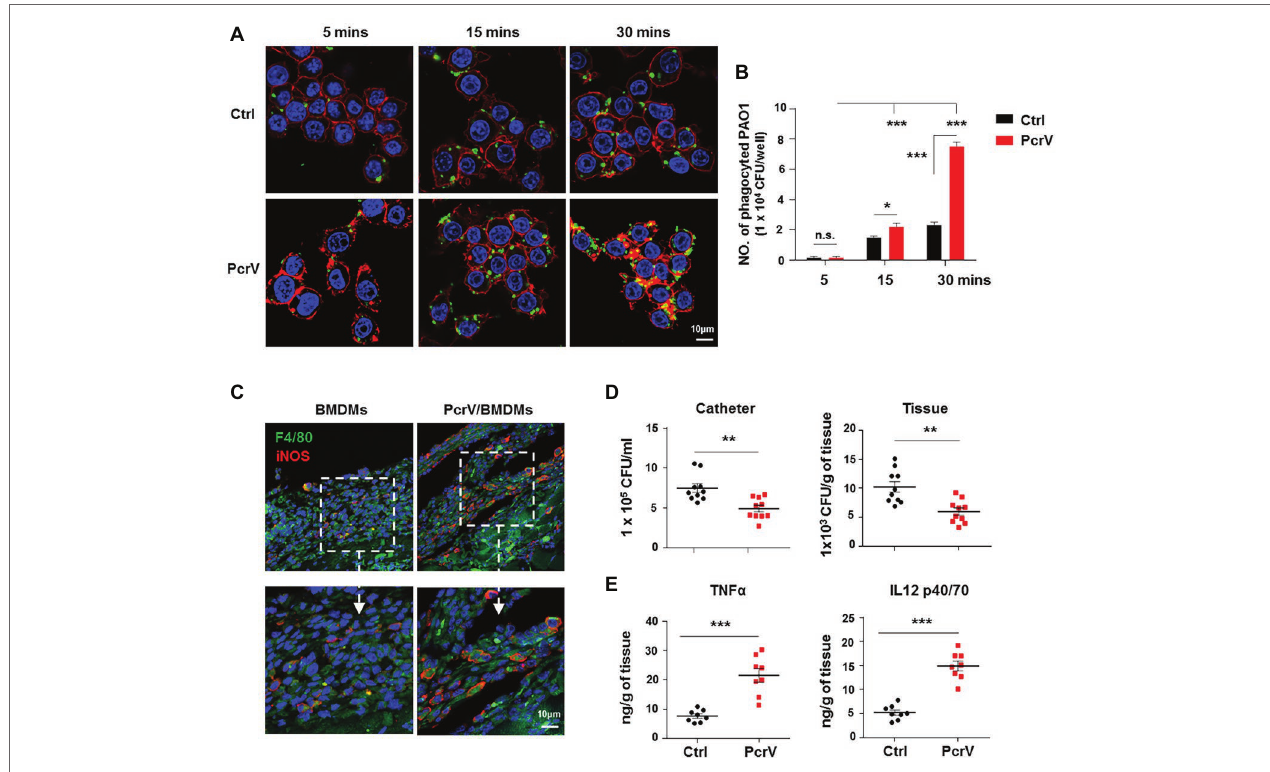
FIGURE 5 | PcrV-primed macrophages display increased phagocytosis, bacterial killing efficacy, and induction of proinflammtory cytokines. Raw264.7 cells pretreated with or without PcrV (10 μ g/ml) for 6 h were co-cultured with P. aeruginosa biofilms (MOI = 10) for the indicated time point. The phagocyted bacteria were detected by immunofluorescence staining (A) and CFU enumeration (B) . Cytoskeleton was labeled with phalloidin (red); PAO1 was visualized by FITC anti-PAO1 antibody (green); cellular nuclei were stained with DAPI (blue). BMDMs primed with or without PcrV (10 μ g/ml) for 24 h were daily injected into the tissues surrounding biofilm-infected catheters after biofilm infection for 4 days. The infected tissues and catheters were harvested after the injection of PcrV for 3 days. F4/80 + /iNOS + macrophages in infected tissues (C) , bacterial burdens (D) , and production of TNF α and IL12 p40/70 (E) were analyzed by immunofluorescence staining, CFU enumeration, and ELISA, respectively. For immunofluorescence staining, M1 macrophages were counterstained with FITC-conjugated anti-F4/80 and AF647- conjugated anti-iNOS antibodies. M2 macrophages were counterstained with FITC-conjugated anti-F4/80 and AF647-conjugated anti-Arg1 antibodies; cellular nuclei were stained with DAPI. One-way ANOVA (Tukey’s post hoc , B ) or unpaired Student’s t test (D,E) was used for statistical analysis. * p < 0.05; ** p < 0.01; *** p <